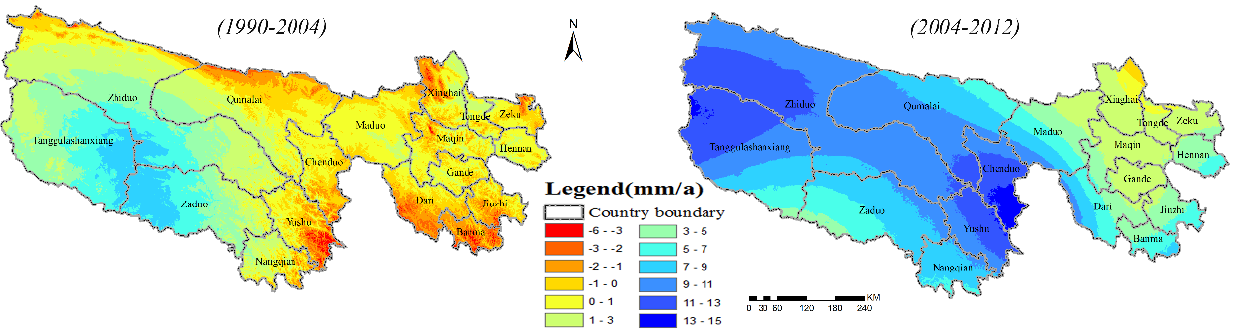
Figure 8. Spatial distribution of annual average precipitation trend rate in the TRH